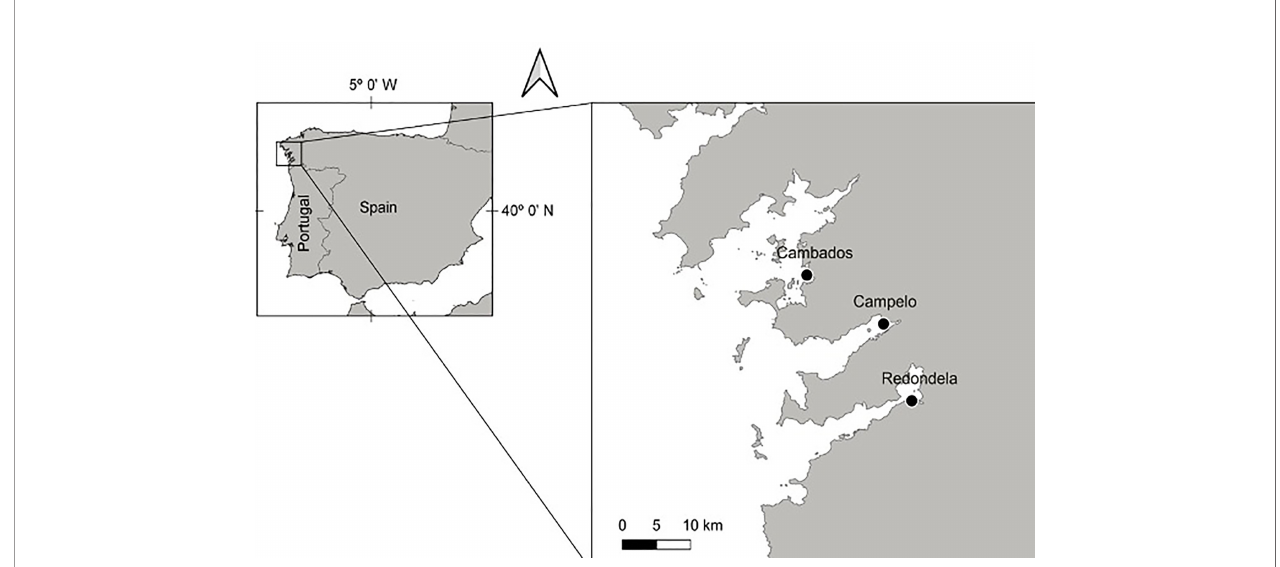
FIGURE 1 | Map of the Galician rias, highlighting the location of Cambados, Campelo and Redondela fi shing